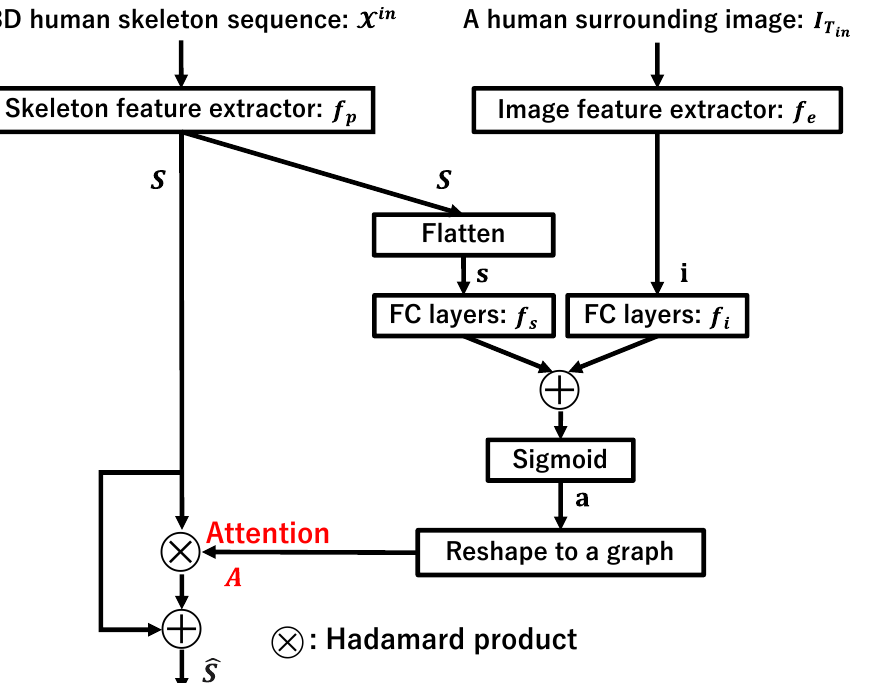
Figure 3. The structure of the IAA module. The skeleton feature extractor is a graph convolution layer of any existing GCN-based prediction model. A surrounding image feature i is used to calculate the attention matrix A for modifying the original skeleton feature S